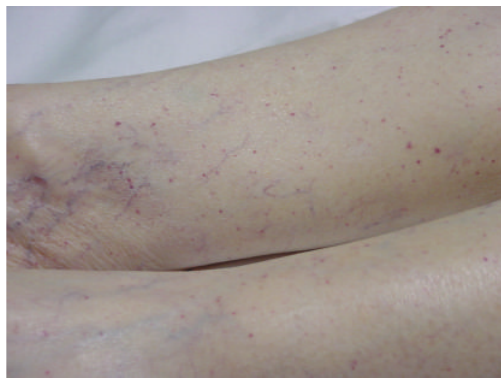
Figure 1: Typical petechial rash on patient’s lower extremities.